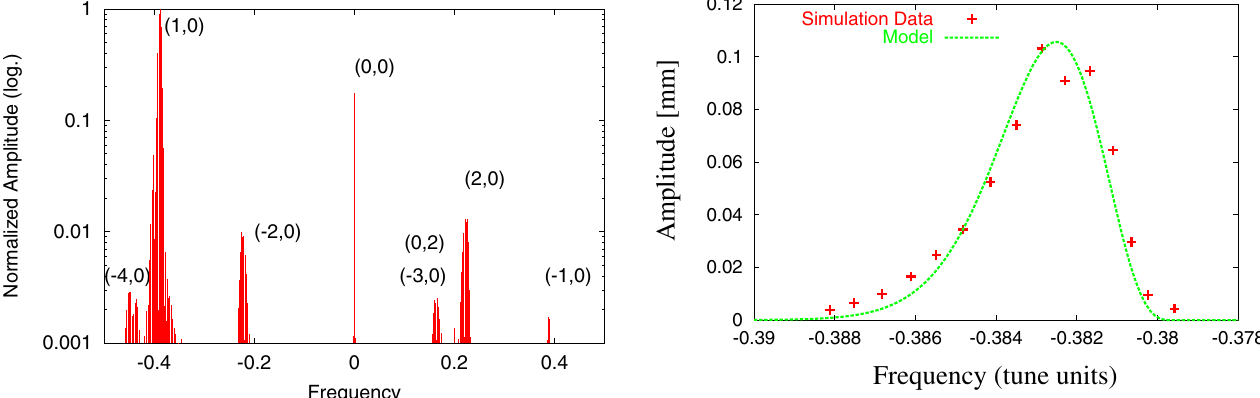
FIG. 3. (Color) Distribution of the tune peak for model and simulation versus frequency (in tune units) for the SPS with extraction sextupoles on.